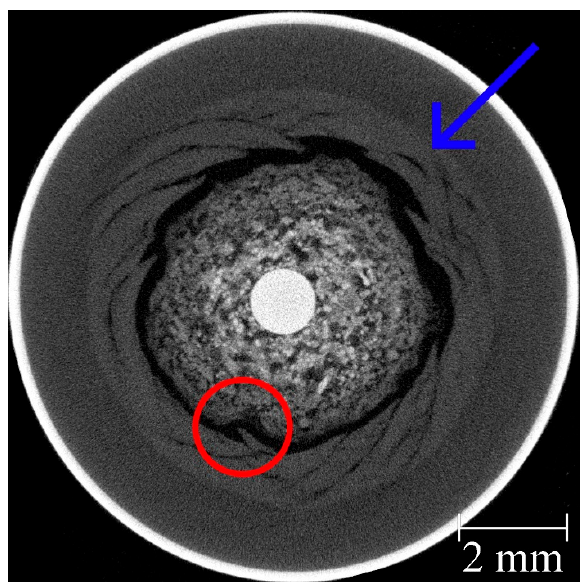
Figure 8. Tomographic cross section of the primary cell after 12 cycles.